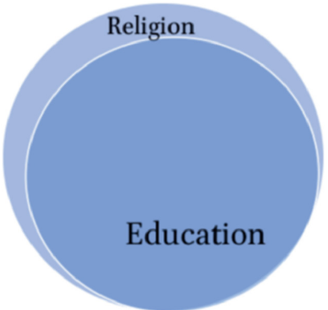
Figure 1. Education into religion and the communitarian purpose of religious.